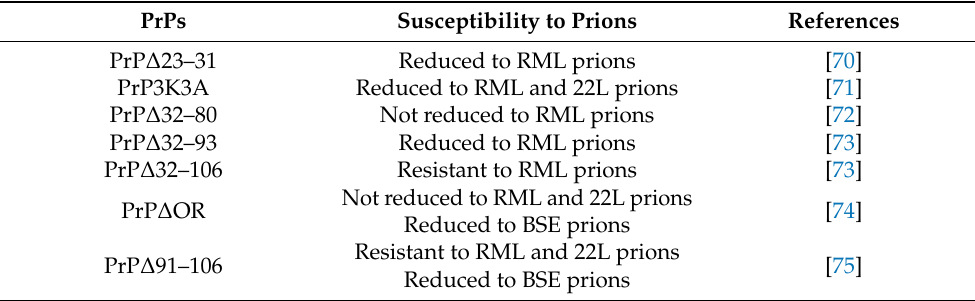
Table 2. PrP deletional and point mutants in prion